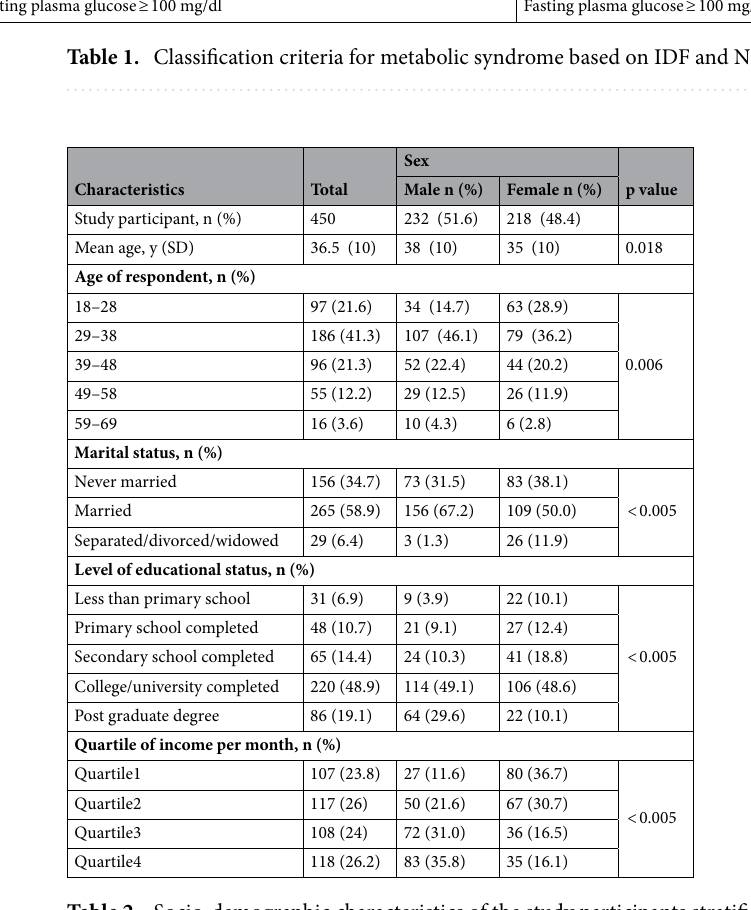
Table 2. Socio-demographic characteristics of the study participants stratified by sex, EPHI, Addis Ababa, Ethiopia, 2018 (n = 450). Quartile 1 = < 1500 Birr, Quartile 2 = 1500–3173-birr, Quartile 3 = 3174–6676-birr Quartile 4 = > 6677